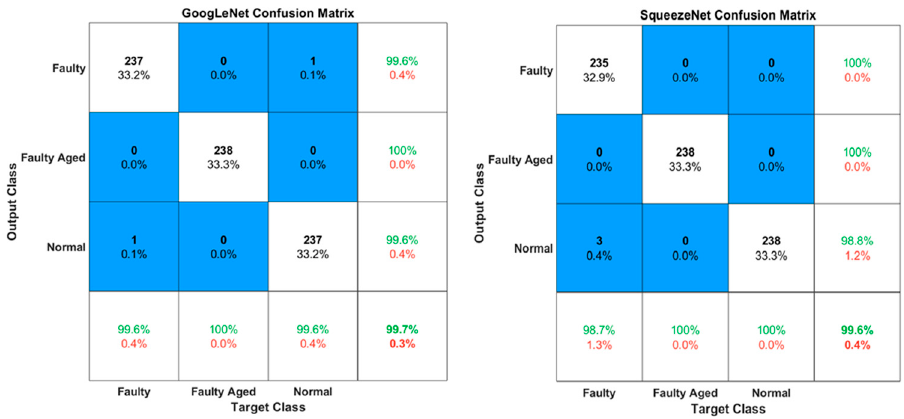
Figure 22. Confusion matrices for GoogLeNet and